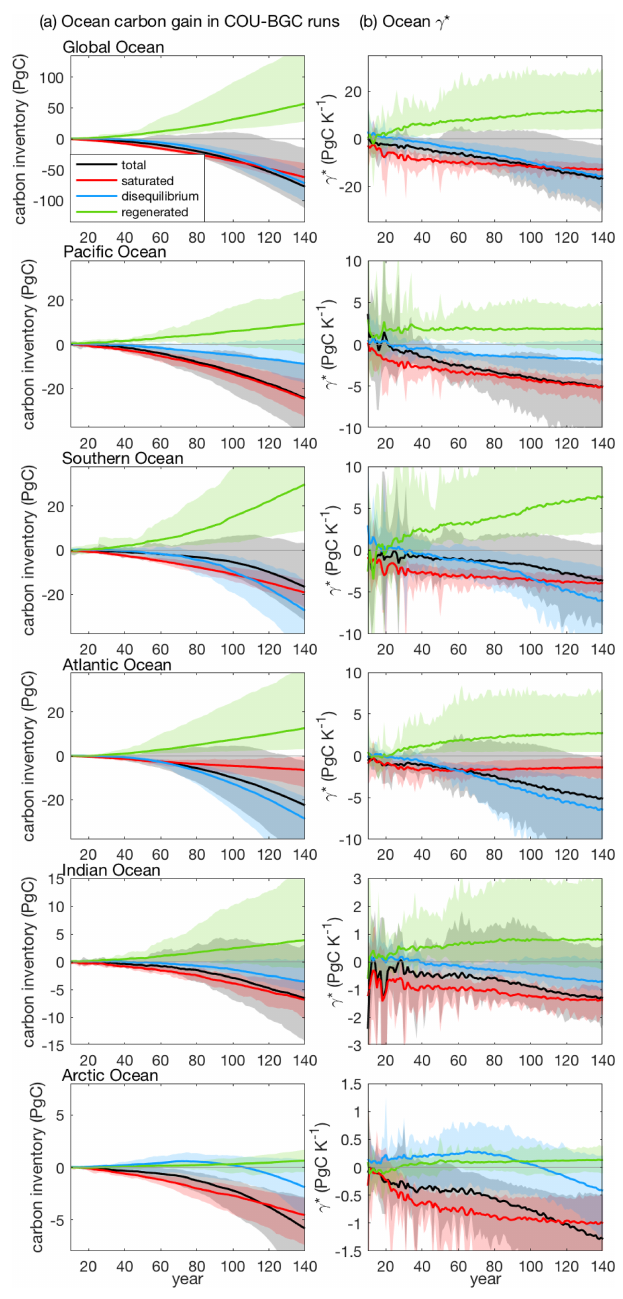
Figure 4. Ocean carbon storage and ocean carbon–climate feed- back parameter, γ ∗ , for the global ocean and different ocean basins, along with the contribution from the saturated, disequilib- rium and regenerated carbon pools in CMIP6 Earth system models: (a) ocean carbon inventory changes in the fully coupled simulation (COU) minus the biogeochemically coupled simulation (BGC) and (b) ocean carbon–climate feedback parameter based on carbon stor- age, γ ∗ (PgC K − 1 ). The solid lines and the shading show the model mean and the model range, respectively, based on the 1%yr − 1 in- creasing CO 2 experiment over 140 years in 11 CMIP6 models (Ta- ble 1). Note that for the global ocean, γ ∗ is equivalent to γ